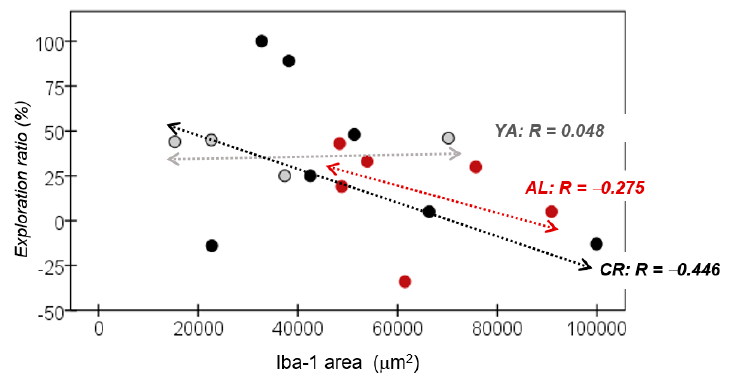
Figure 7. YA, young adult; AL, ad libitum; CR, caloric restriction.